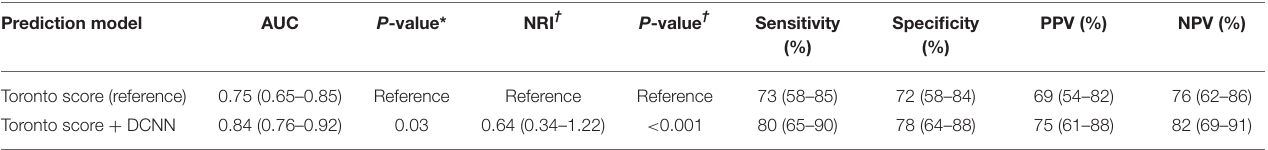
TABLE 3 | Predictive performance of Toronto score and a new model combining Toronto score and deep convolutional neural network-based probability to predict positive genotype in patients with hypertrophic cardiomyopathy. Prediction model